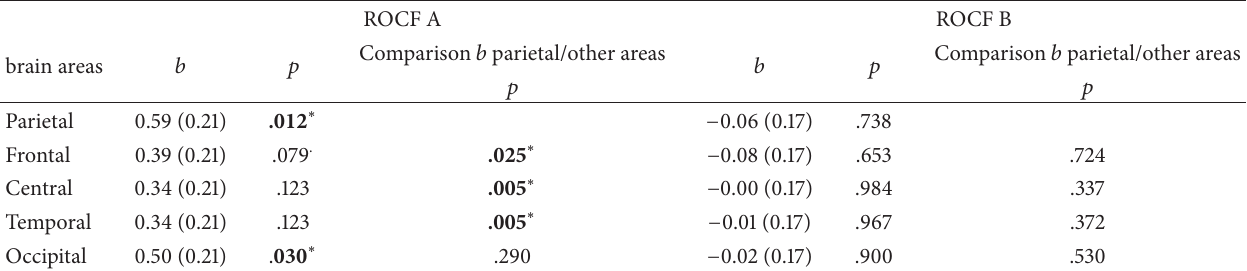
Table 4: Correlation between alpha/theta ratio and Rey-Osterrieth Complex Figure Test. ROCF A ROCF B